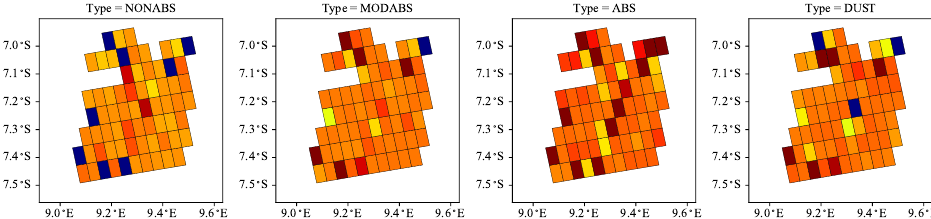
Figure 13. The same as in Figure 10 but for the data on 5 July 2019.